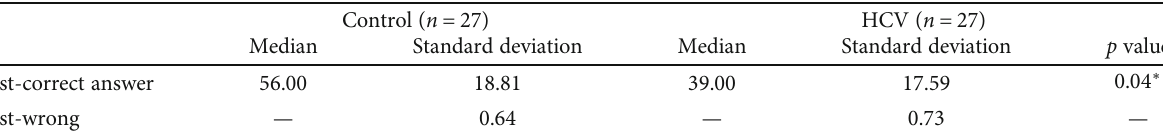
Table 5: Descriptive statistics of code testing.